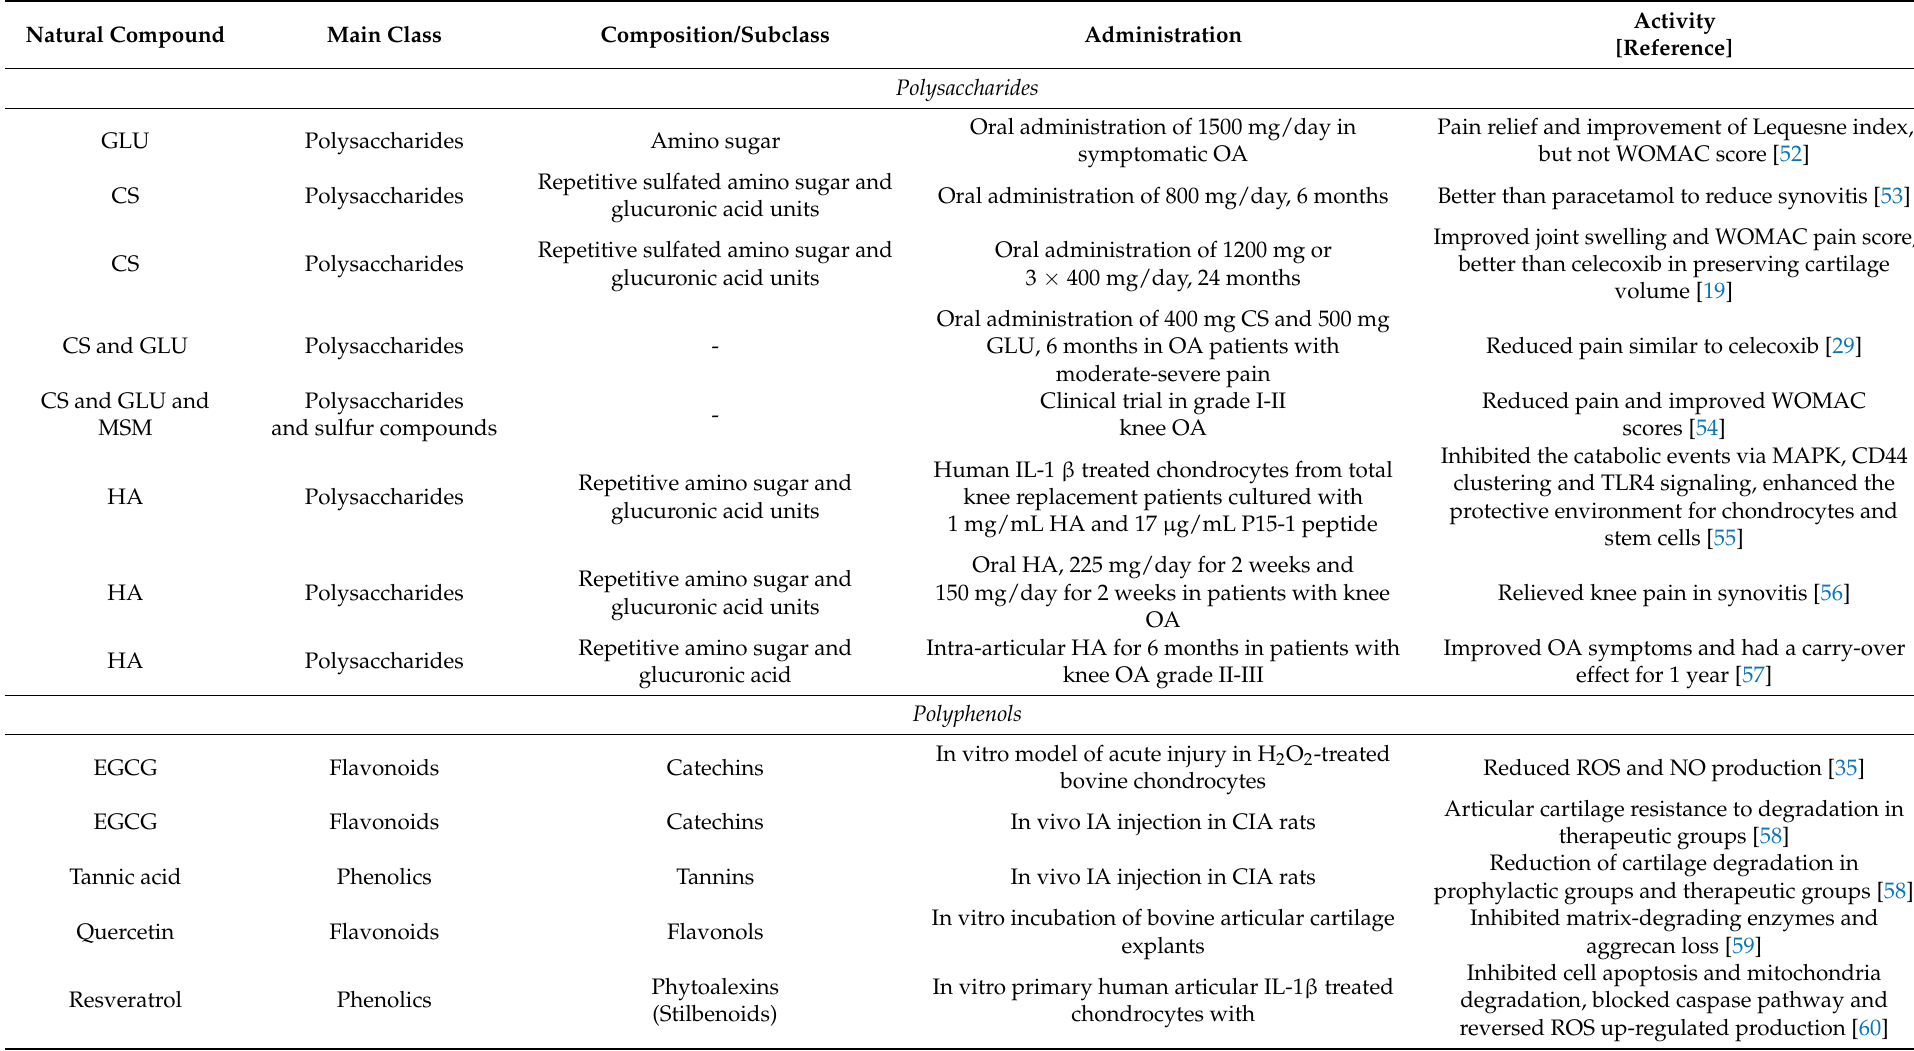
Table 1. Natural compounds with anti-inflammatory activity used for OA